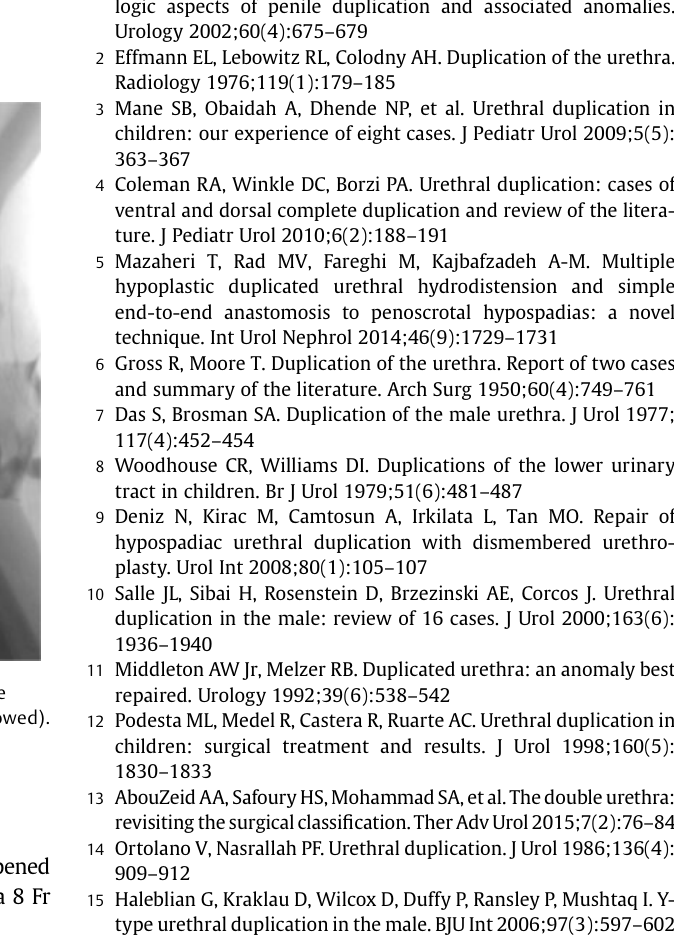
Fig.2 Operative procedure. ( A ) Preoperative picture (thearrowsshow the position of the two urethral meati). ( B ) Intraoperative picture after penile degloving, the dorsal urethra is opened in the midline. ( C ) Immediate postoperative result. ( D ) Follow-up 21 months postoperatively.